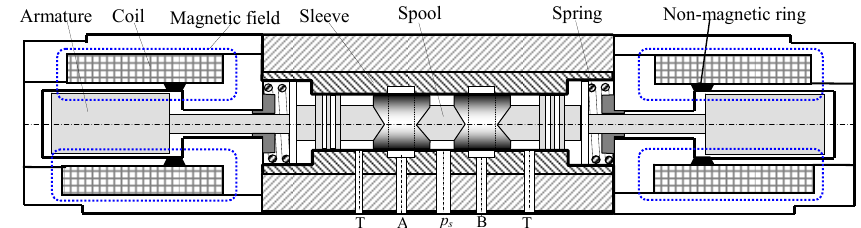
Figure 1. Proportional directional valve.